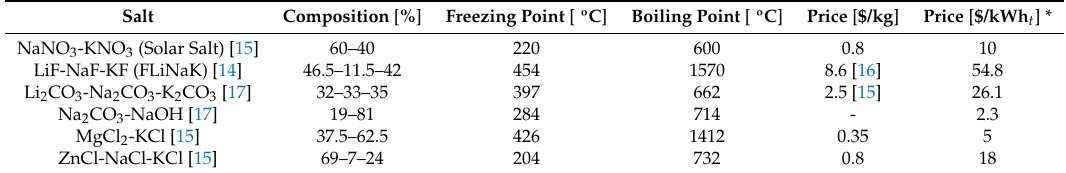
Table 1. Comparison between different molten salts for intermediate-high temperature Concentrated Solar Power (CSP)